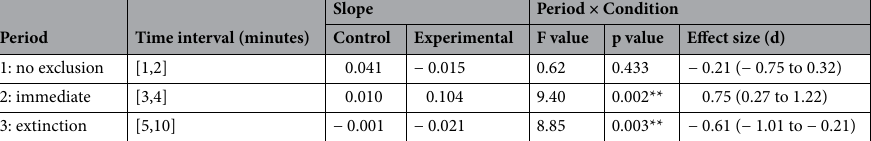
Table 2. Results of piecewise Linear Mixed Models (LMM; experiment 2). Passing preferences were calculated for each minute according to formula [1]; slope represents group-specific change in passing tendency within respective period; significant interaction effect represents difference in group-specific slopes within respective period; effect size calculated as Cohen’s d according to formula [2]. * p < 0.05 ** p < 0.01; *** p < 0.001.